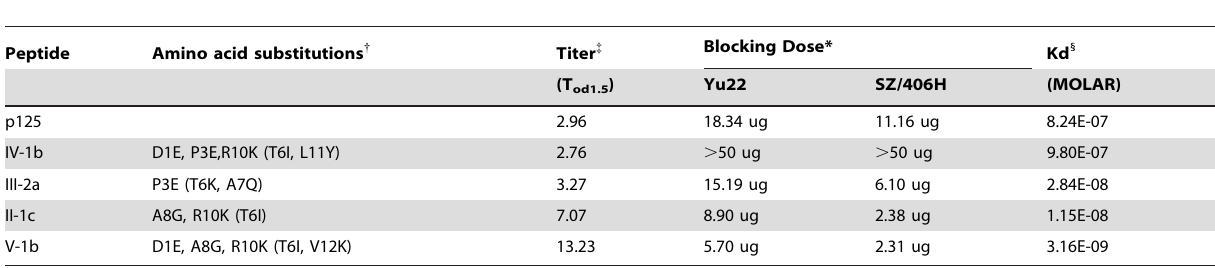
Table 3. 8H5 reactivity and dissociation constants of p125 and related 12mer peptides.